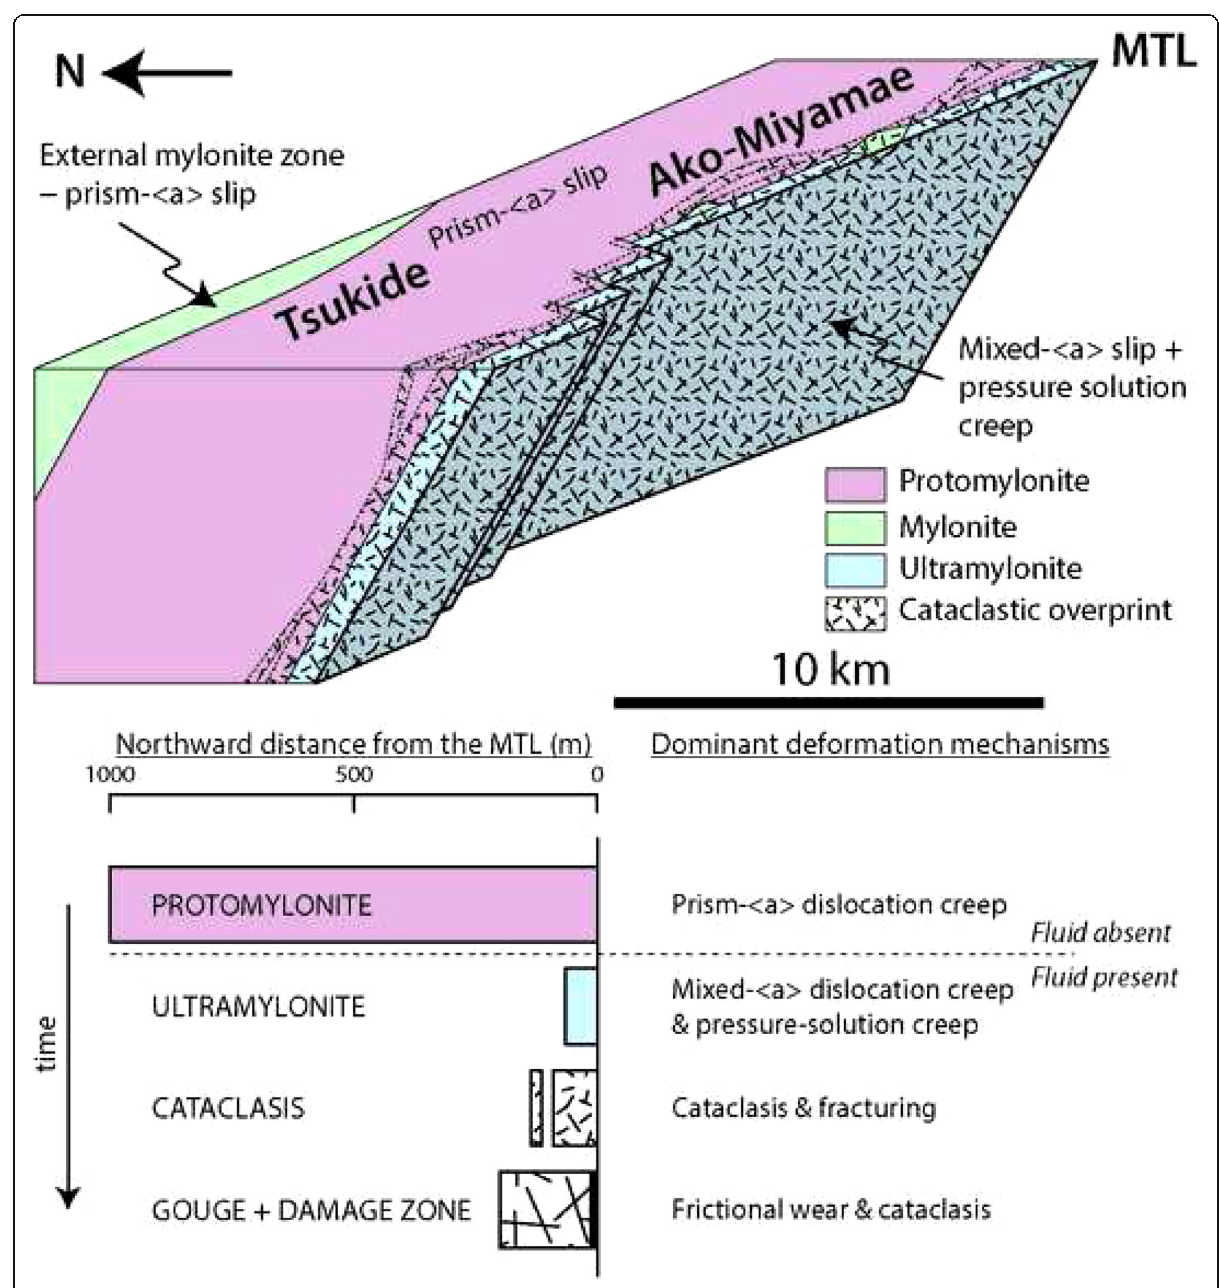
Fig. 14 A summary of the inferred architecture (upper panel) and evolution of fault rocks (lower panel) in the hanging wall of the MTL in the study area. Progressive overprinting was associated with deformation mechanism transitions during uplift and cooling of the fault